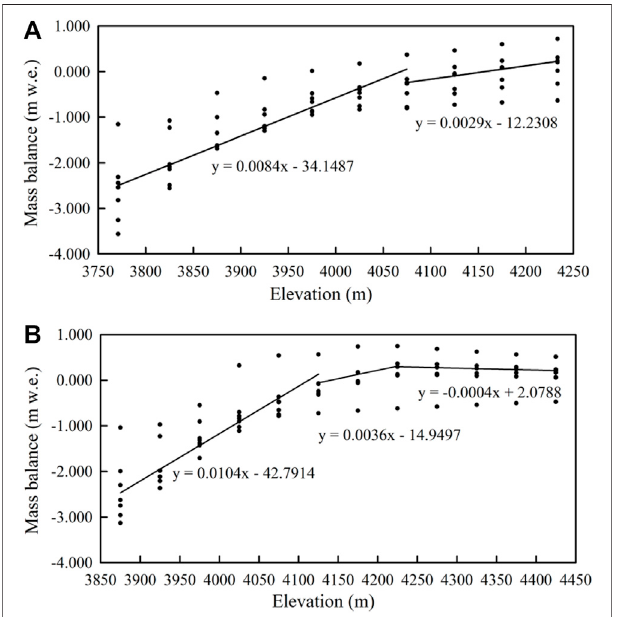
FIGURE4 | The mass balance measurements ofUrumqiGlacier No. 1 ’ s (A) EB and (B) WB from 2006 to 2012, where the line is the fi tted value in ablation or accumulation area.